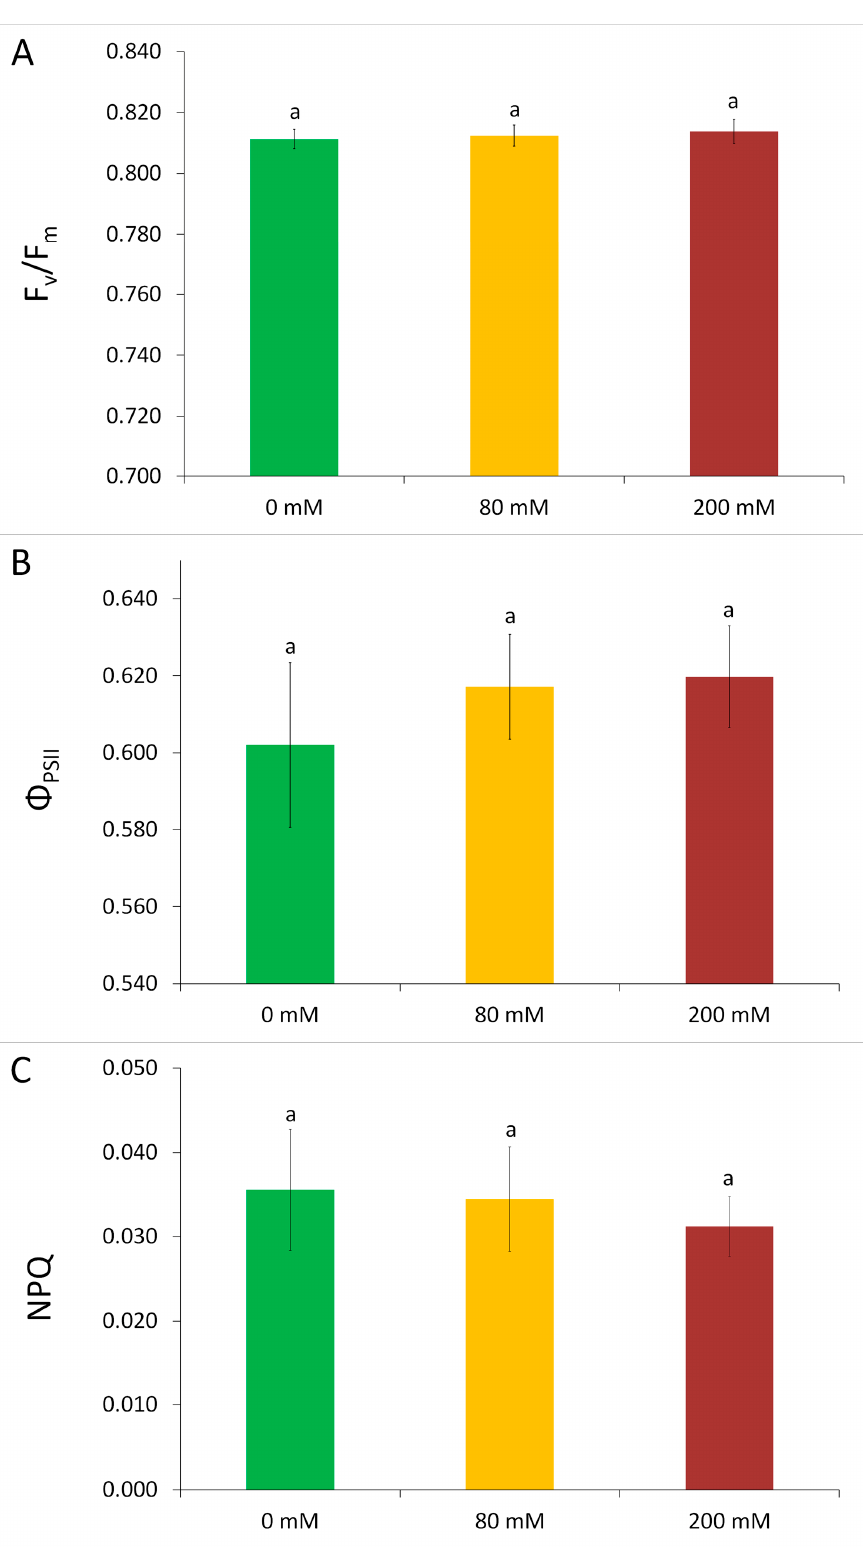
2 Figure 3. Status of the photosynthetic apparatus, modelled by the maximal (F v /F m : A ) and the actual ( Φ PSII : B ) quantum efficiencies of photosystem II reaction centres and the value of non-photochemical quenching (NPQ: C ). Error bars represent SD values. To compare the differences, one-way ANOVA was performed on each dataset with Tukey’s post-hoc test on the treatments ( p < 0.05). Same lowercase letters indicate there are no significantly different